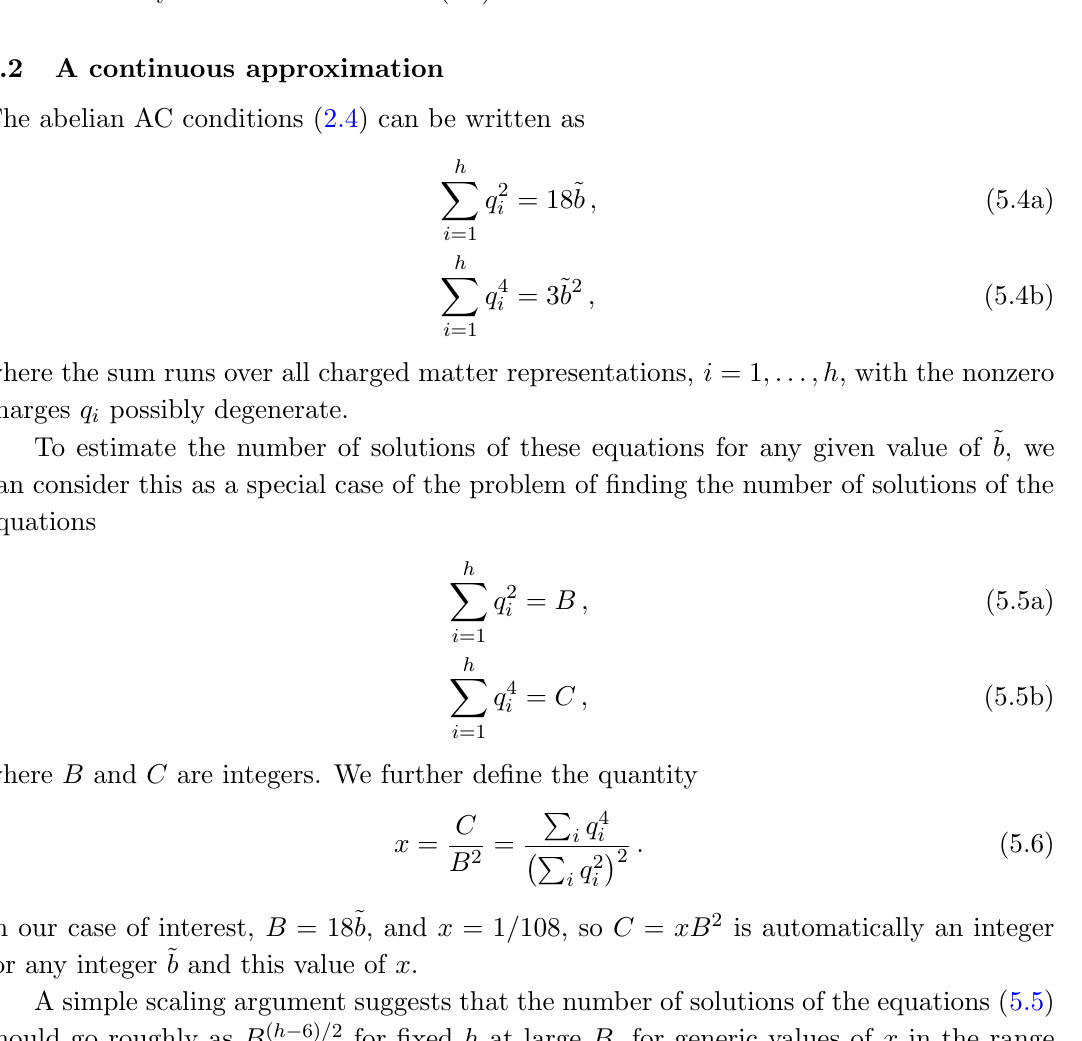
Figure 1 . An integer tuple ( a; b; c; d ) such that there exists an equilateral triangle of side length c with an integral cevian of length d= 2 dividing the side into integral parts, a + b = c . Such tuples produce anomaly-free models of the form